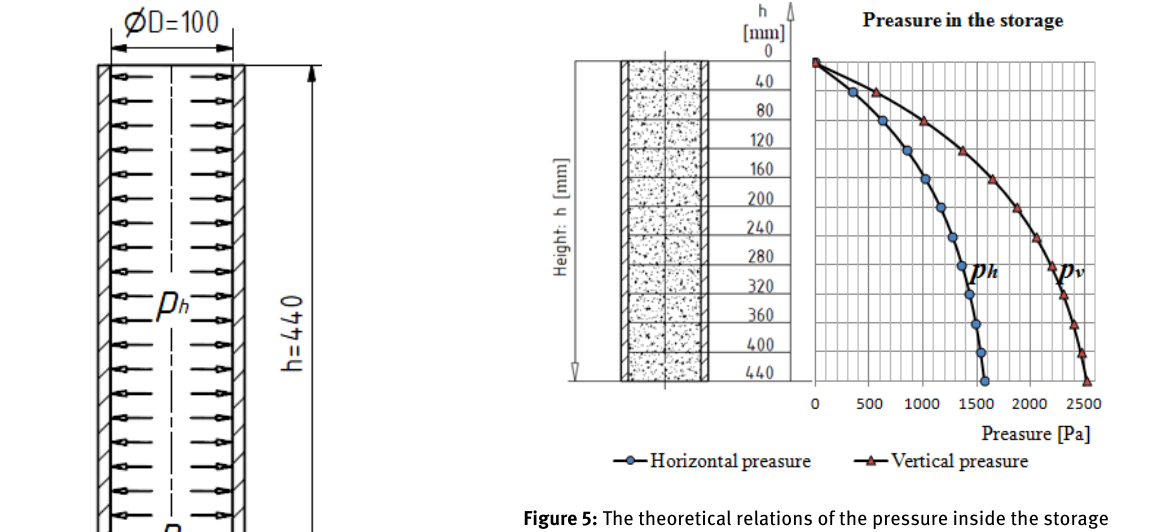
Figure 5: The theoretical relations of the pressure inside the storage